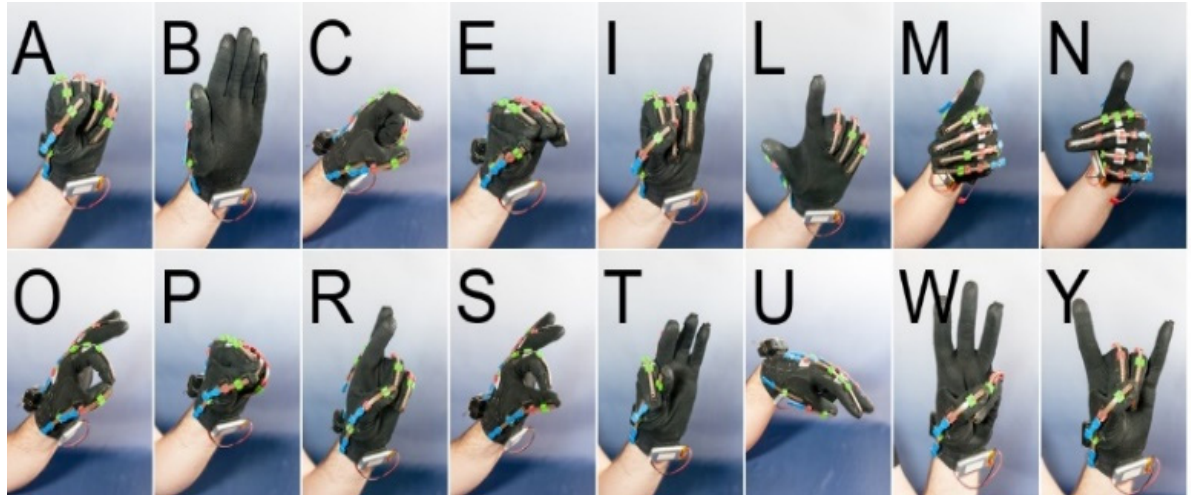
Figure 4. Gestures based on static letters of Polish Sign Language alphabet.